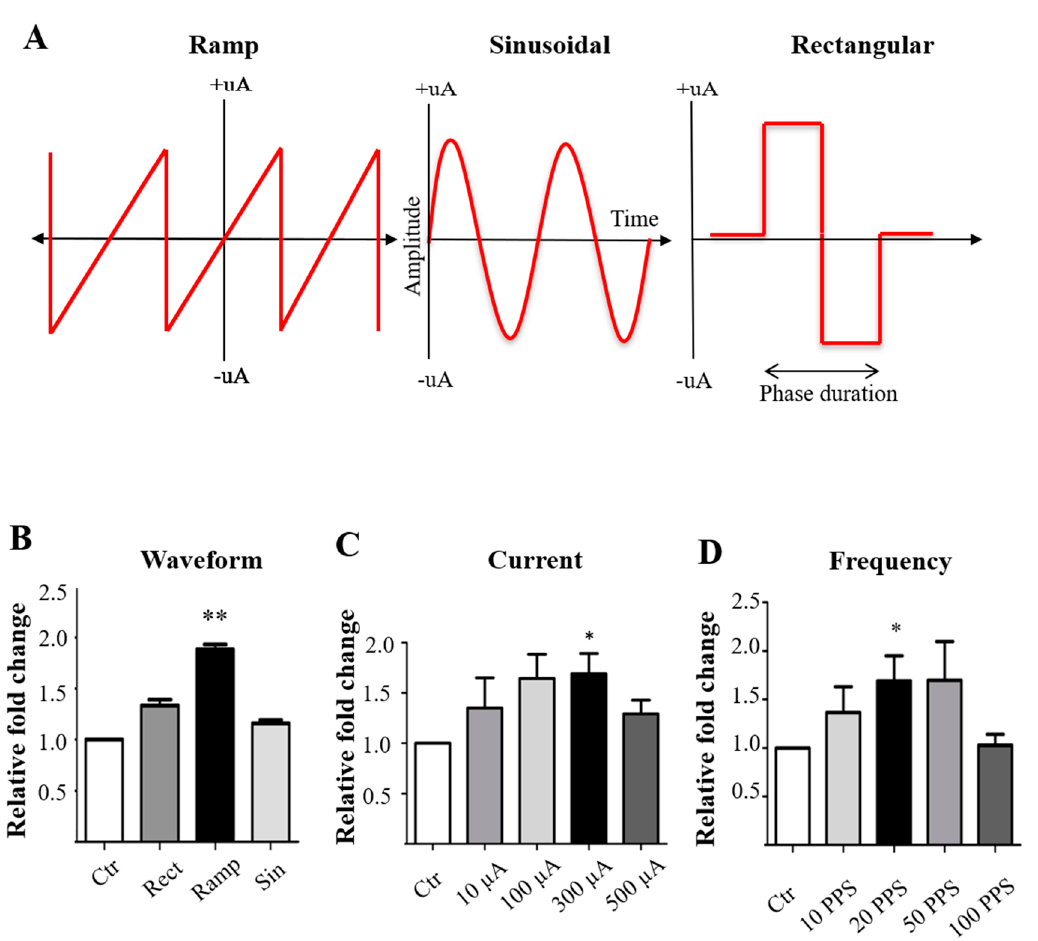
Figure 2. Optimal conditions of ES with a ramp waveform. ( A ) The three waveforms used in the study: ramp waveform with negative and positive ramp, the typical sinusoidal waveform with current fluctuations in a typical sinusoidal pattern, and the biphasic rectangular waveform. ( B ) Changes in MC proliferation following ES of di ff erent waveforms at 20 PPS and 100 µ A. Note that ramp waveform significantly promoted MC proliferation by ~2-fold as compared to the control group. ( C ) Changes in MC proliferation when stimulated with ramp waveforms of ES at 20 PPS and di ff erent current levels. Paired t -test, p < 0.05 compared to controls. ( D ) Changes in MC proliferation with ES of fixed 300 µ A current and ramp waveform at various frequencies. Note that 20 PPS yielded significantly increased MC proliferation. Value = means ± S.E.M. * p < 0.05, ** p < 0.01 compared to controls by paired t -test ( n = 5 /